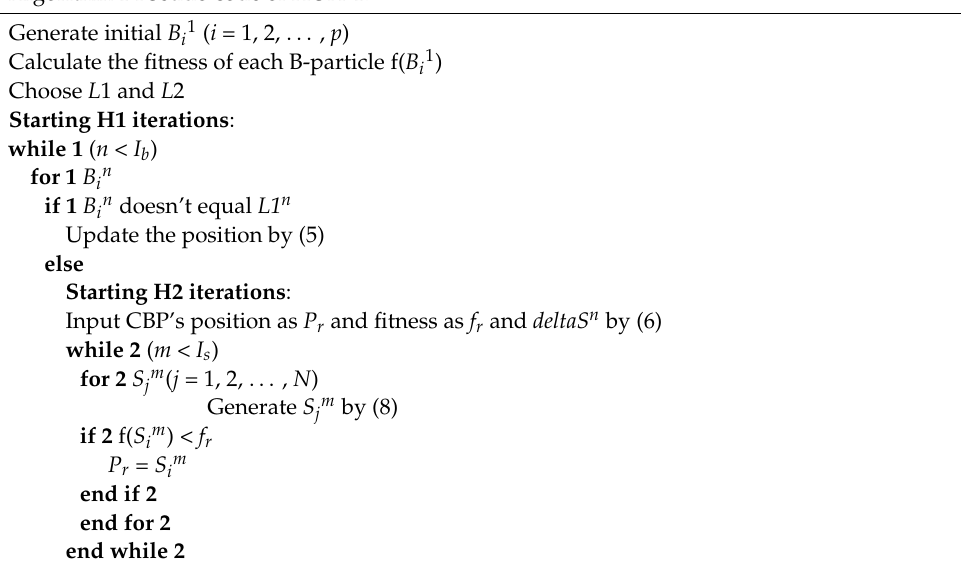
Algorithm 1 Pseudo code of